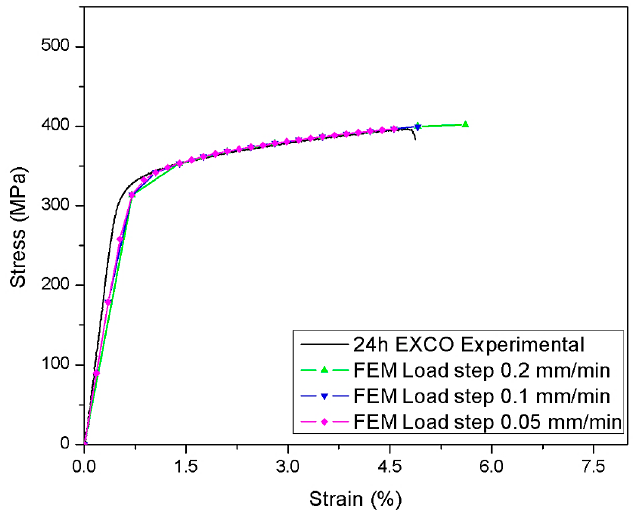
Figure 10. Results of the convergence study performed on the effect of incremental axial displacement reduction.